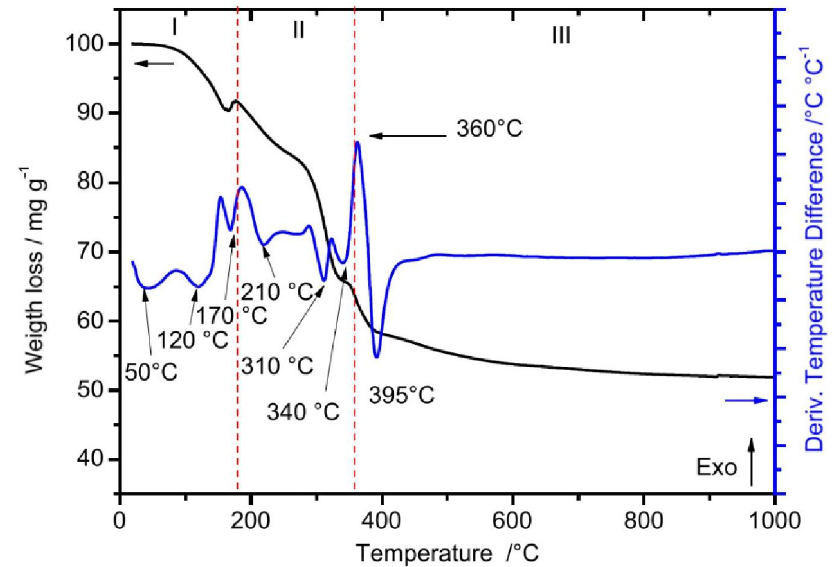
Figure 1. Differential Thermal Gravimetry (DTG) and differential thermal analyses (DTA) O : 5 mol % Eu 3+ , 0.01 mol % Tb 3+ xerogel profiles of Lu 2 3